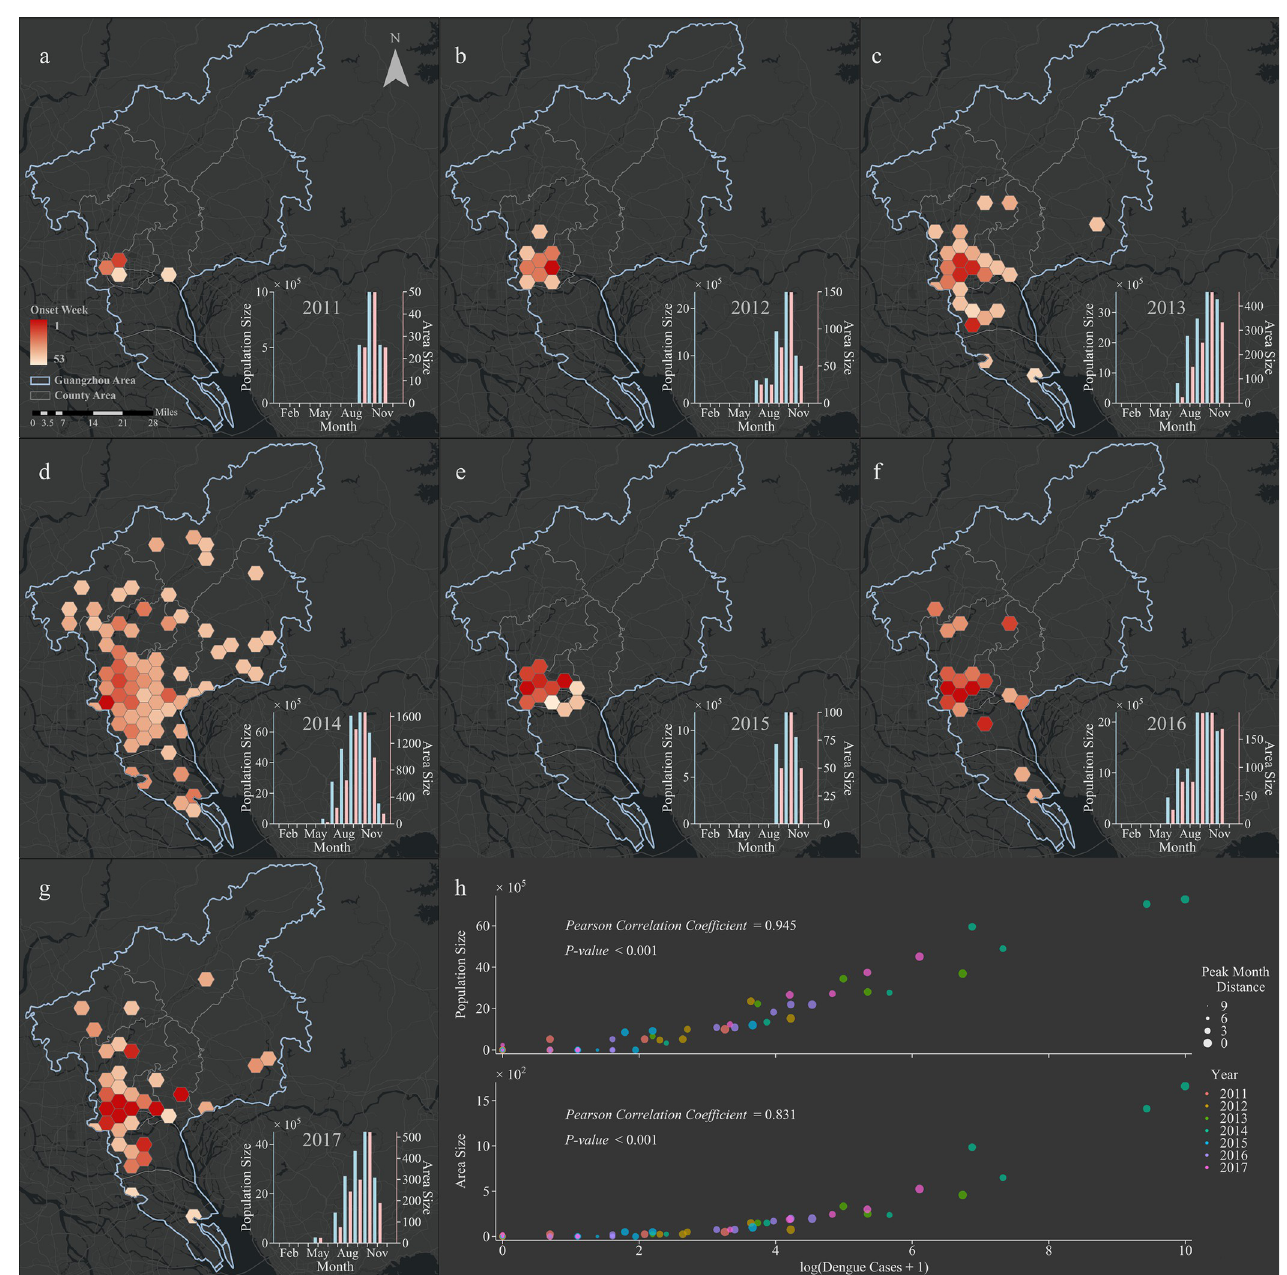
Fig 2. The spatial transmission pattern of dengue fever and its monthly changes of population size and area affected by the epidemic from 2011 to 2017. a-g The temporal and spatial spread of the epidemic in Guangzhou from 2011 to 2017. The onset week of administrative regions has shown. Small figures inset of a-g show the monthly change trend of population size and area affected by the epidemic. h Scatter plots displaying the relationship between monthly new infections and the population size and area affected by the epidemic. The distance of peak month and different years are respectively distinguished by the size and color of scatter. The results of Pearson correlation analysis are also shown. Base map sourced from the DIVA-GIS (https : //www . diva-gis . org/gdata) .